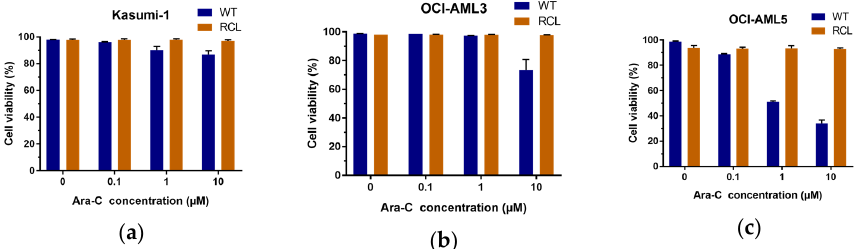
Figure A1. Cell viability of resistant and parental cell lines following treatment with increasing Ara-C concentrations. Resistant (RCL) and wildtype (WT) variants of AML cell lines Kasumi-1 ( a ), OCI-AML3 ( b ), OCI-AML5 ( c ) were plated with different concentrations of Ara-C ranging from 100 nM to 10,000 nM. Cell viability was determined after 3 days with the Trypan Blue dye exclusion method.